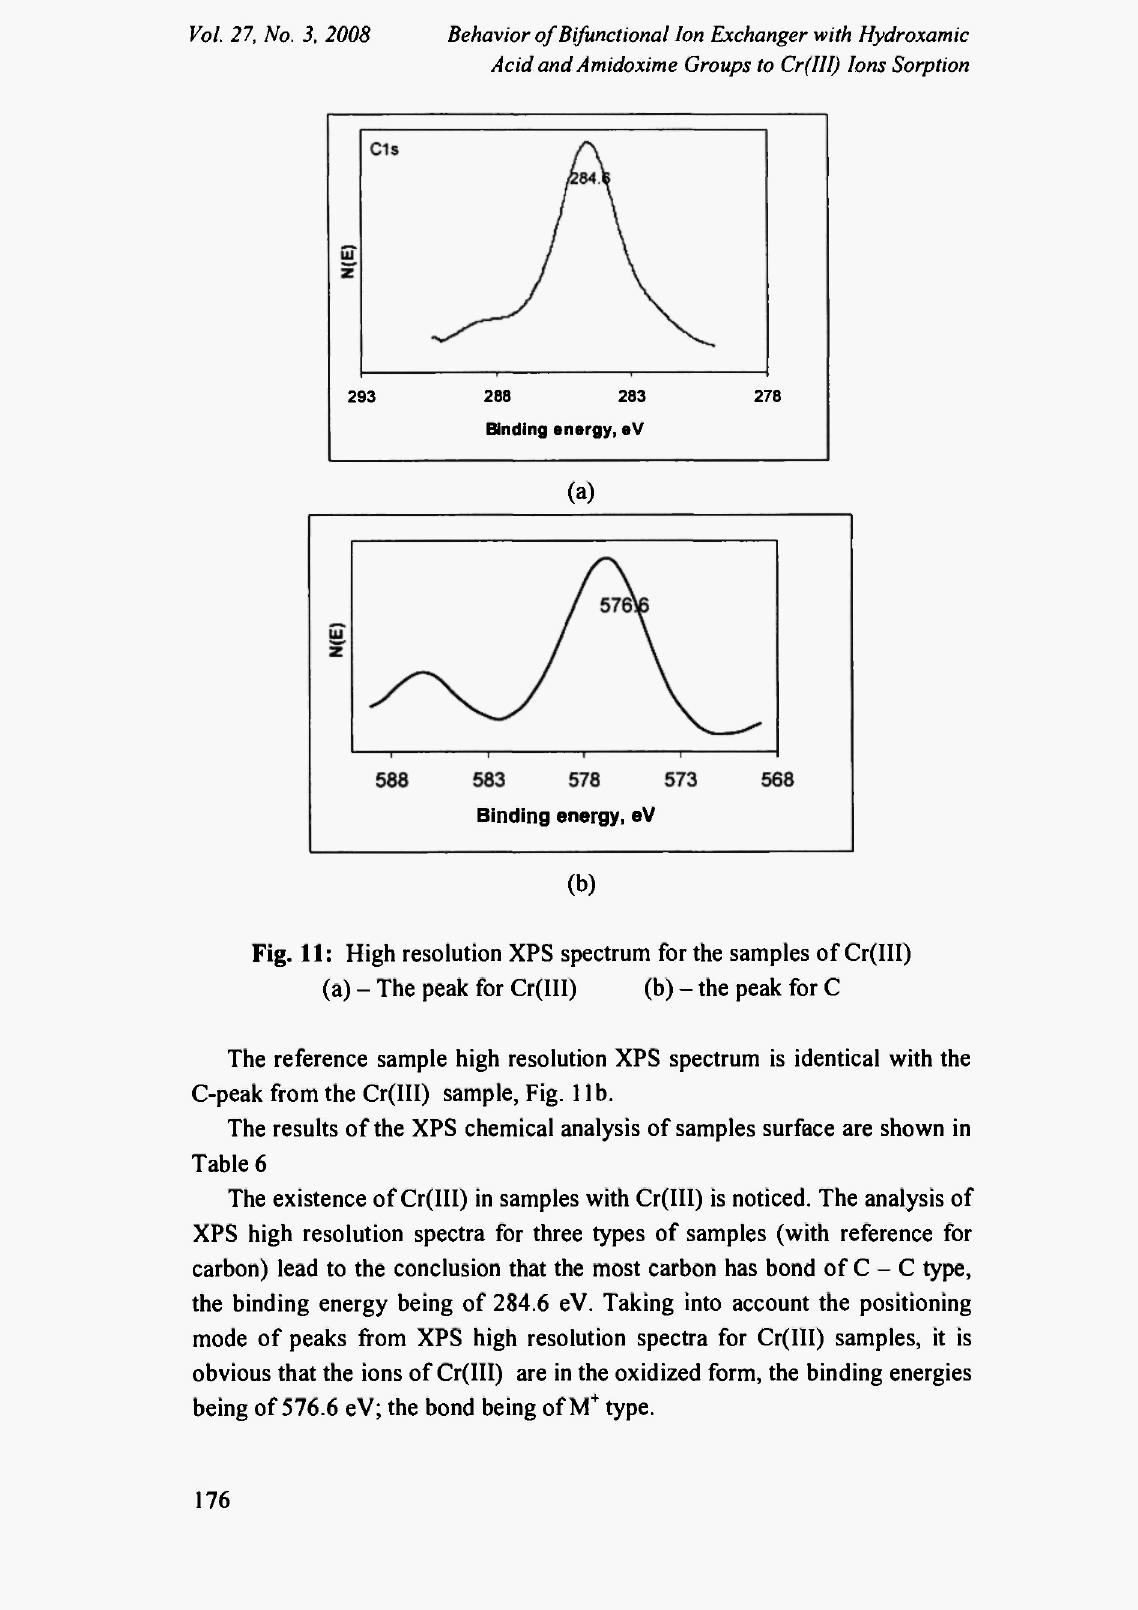
Fig. 11: High resolution XPS spectrum for the samples of Cr(III) (a) - The peak for Cr(III) (b) - the peak for C